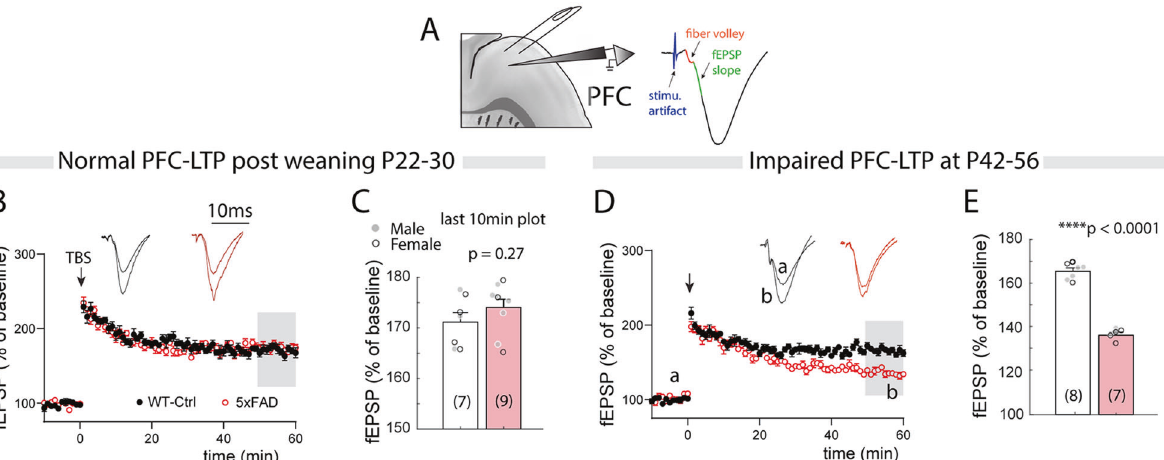
Fig. 2 5xFAD mice show impaired PFC-L5 LTP at 6 – 8 weeks age. A Schematic illustration of fEPSP recording from L5 in sagittal PFC slices. B 5XFAD slices from P22 – 30 mice show similar levels of LTP induction and maintenance compared to WT littermates. C Quanti fi cation of LTP magnitude of the last 10 min post-induction recordings show no signi fi cant change (WT, n = 7 mice; 5XFAD, n = 9 mice. t 14 = 1.15, p = 0.27). Open markers for bar graph, female; closed markers, male. D PFC-L5 LTP magnitude in 5XFAD mice was dramatically reduced at age P42 – 56. E Quanti fi cation of the last 10 min LTP recordings show signi fi cant reduction in 5XFAD slices (WT, n = 8 mice; 5XFAD, n = 7 mice. t 13 = 16.9, **** p <